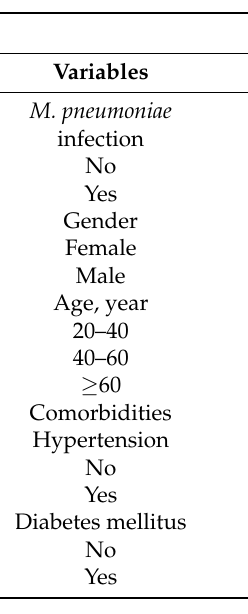
Table 2. Incidence rate and hazard ratio of myasthenia gravis